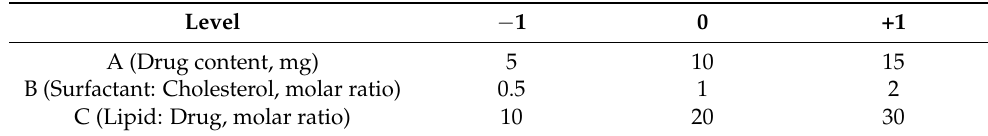
Table 1. Amounts of variables in the Box–Behnken optimization.